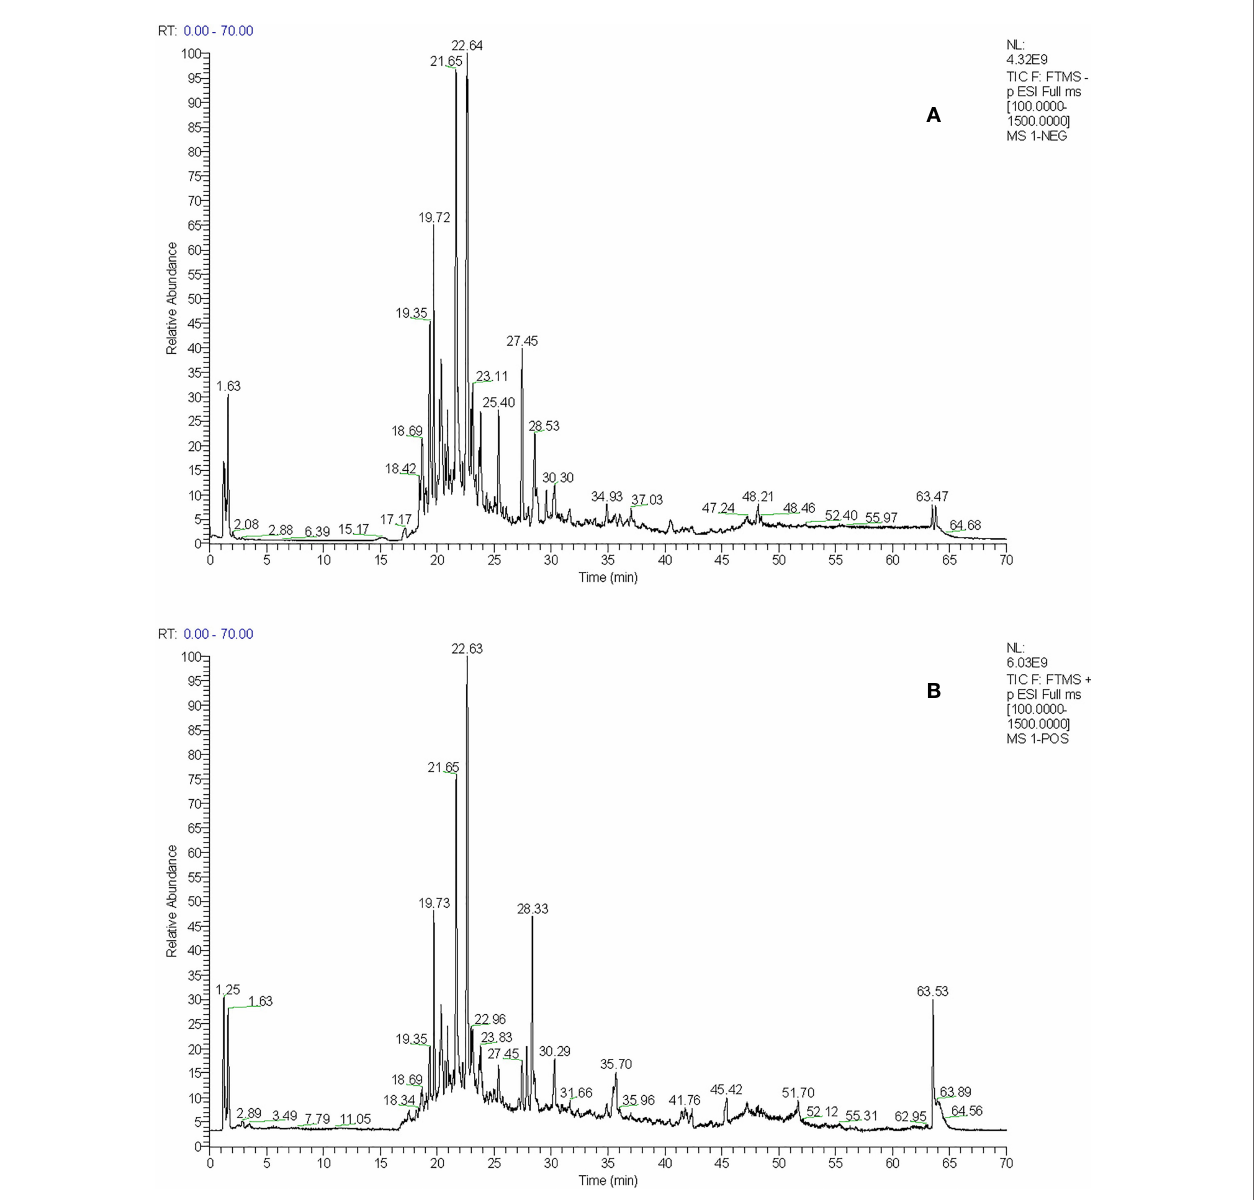
FIGURE 1 | (A) The total ion chromatogram of TFDR in negative ion mode (B) The total ion chromatogram of TFDR in positive ion